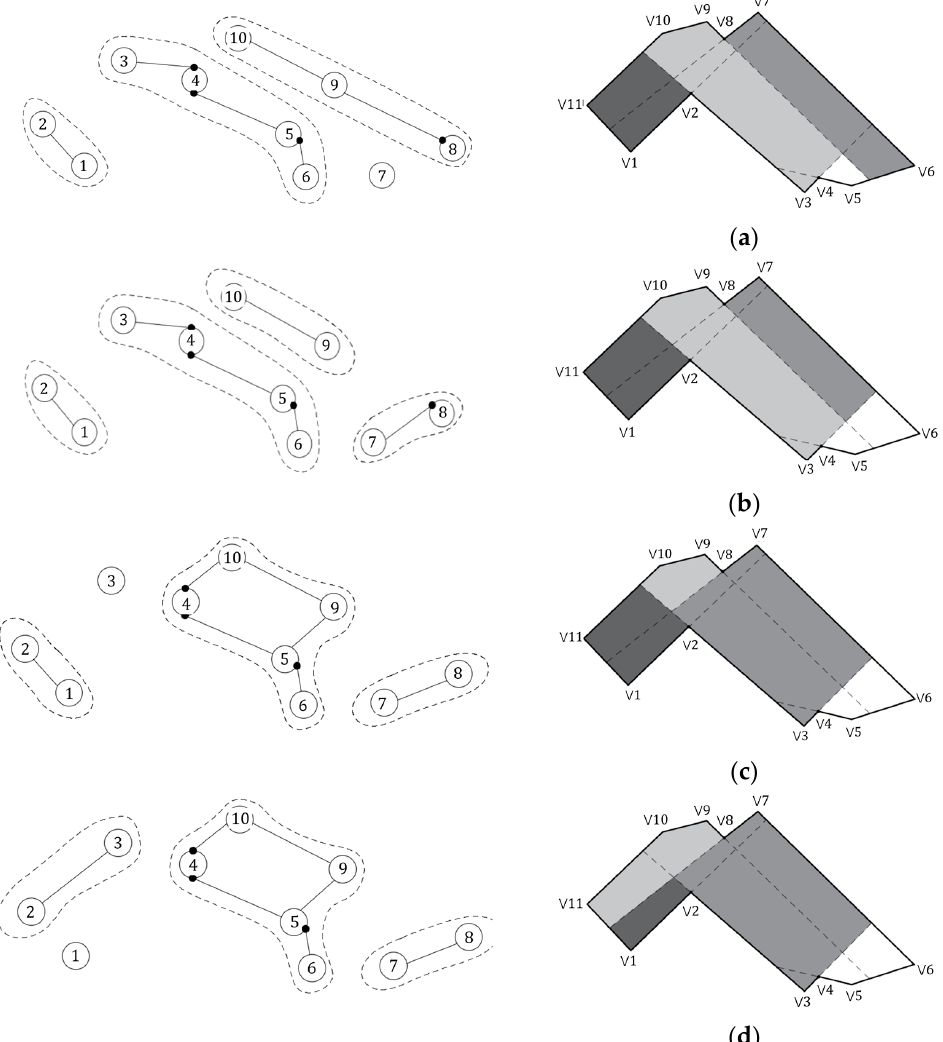
Figure 18. Undirected graph decomposition and sub-region merging based on node 6. ( a ) Scheme 1; ( b ) scheme 2; ( c ) scheme 3; ( d ) scheme 4.